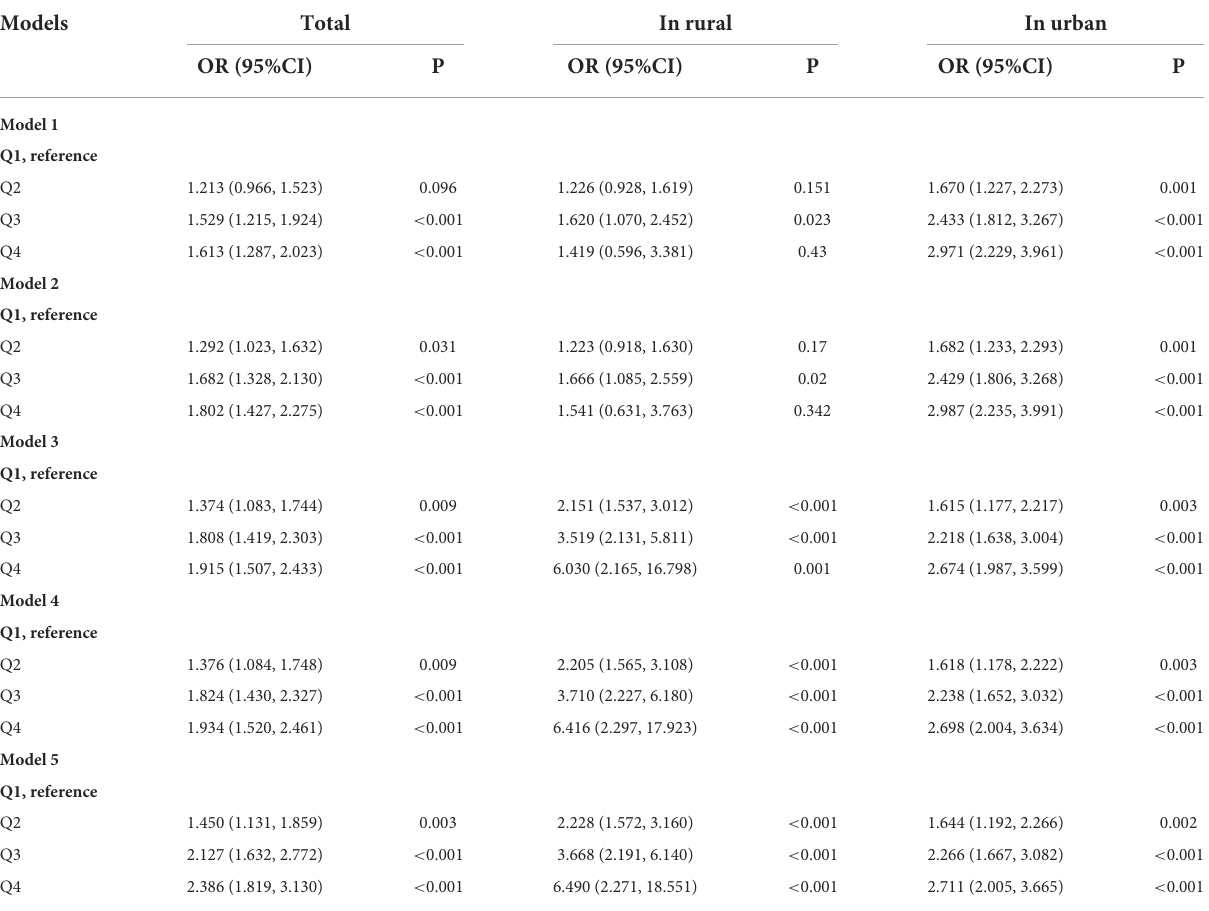
TABLE 5 The logistic regression analysis of quartile range increase of the RC level with abdominal obesity.